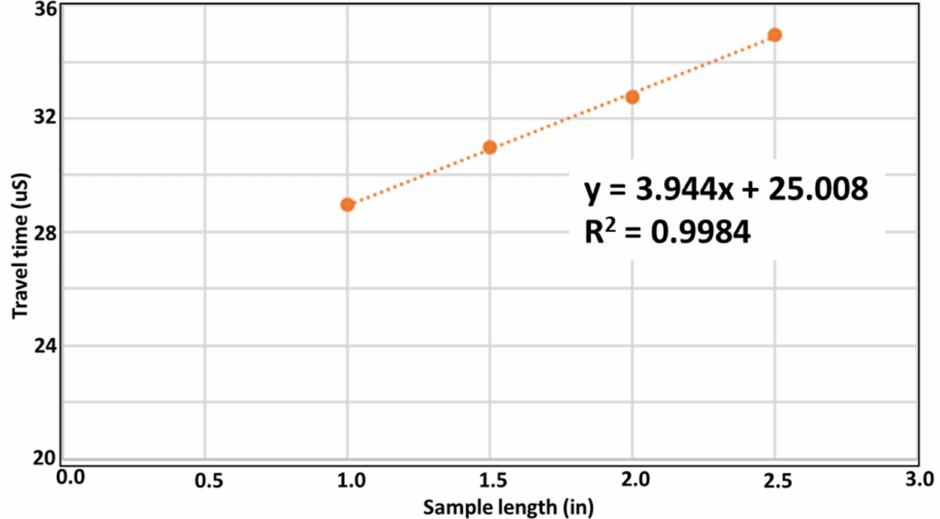
Figure 4. Plot of P-wave arrival times (in microsecond units) measured on 1 (cid:48)(cid:48) , 1.5 (cid:48)(cid:48) , 2 (cid:48)(cid:48) , and 2.5 (cid:48)(cid:48) Aluminum billets. The inverse of the slope—0.2535 in/us (6.439 km/s)—is the P-wave velocity of aluminum, which is within 0.5% of published P-wave velocity for aluminum (6.42 km/s)